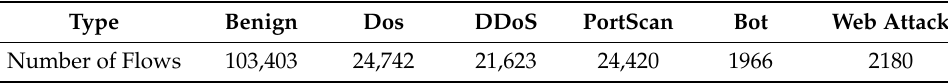
Table 5. Datasets description.